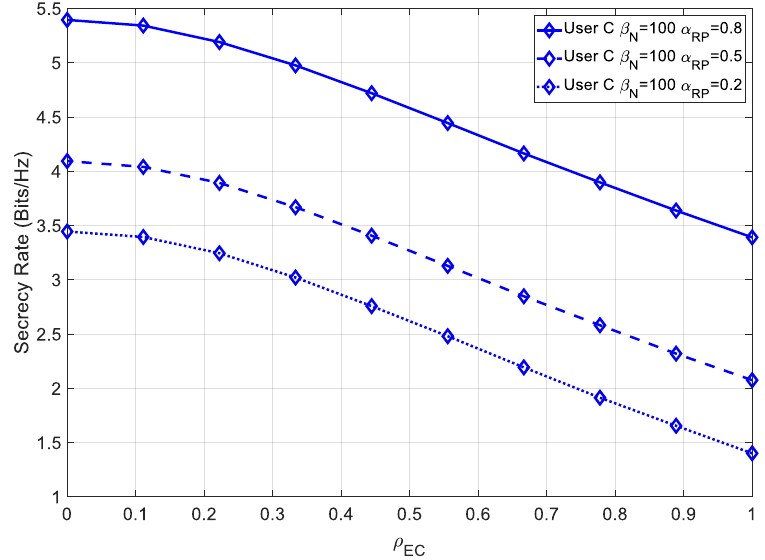
Figure 14. Secrecy rate of the 8 × 8 receiver C with channel estimation errors on both the receiver and eavesdropper, for various ray power coefficients.